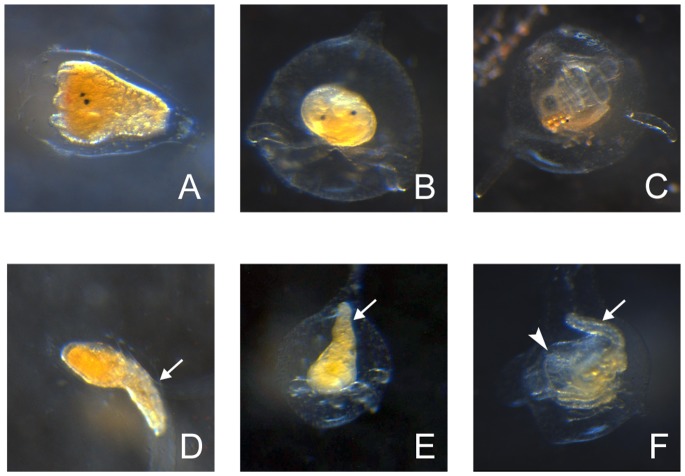
Normal (25°C) and abnormal (32°C) post-larval development of Herdmania momus.
(A) Normal 4 hpi post-larva. Black eyespots and ampullae growth are visible at the anterior end, left. (B) Normal 24 hpi post-larva. Ampullae are fully extended, bottom. (C) Normal 84 hpi post-larva. Adult morphology has been formed by this time; branchial basket and siphons can clearly be seen. (D) Abnormal 4 hpi post-larva. Arrow indicates incompletely resorbed tail at posterior end. (E) Abnormal 24 hpi post-larva. Arrow indicates some larval tail still remaining. (F) Abnormal 84 hpi post-larva. Arrow indicates some larval tail still remaining; arrowhead indicates deformed branchial basket. Scale bars: A-F, 100 µm.